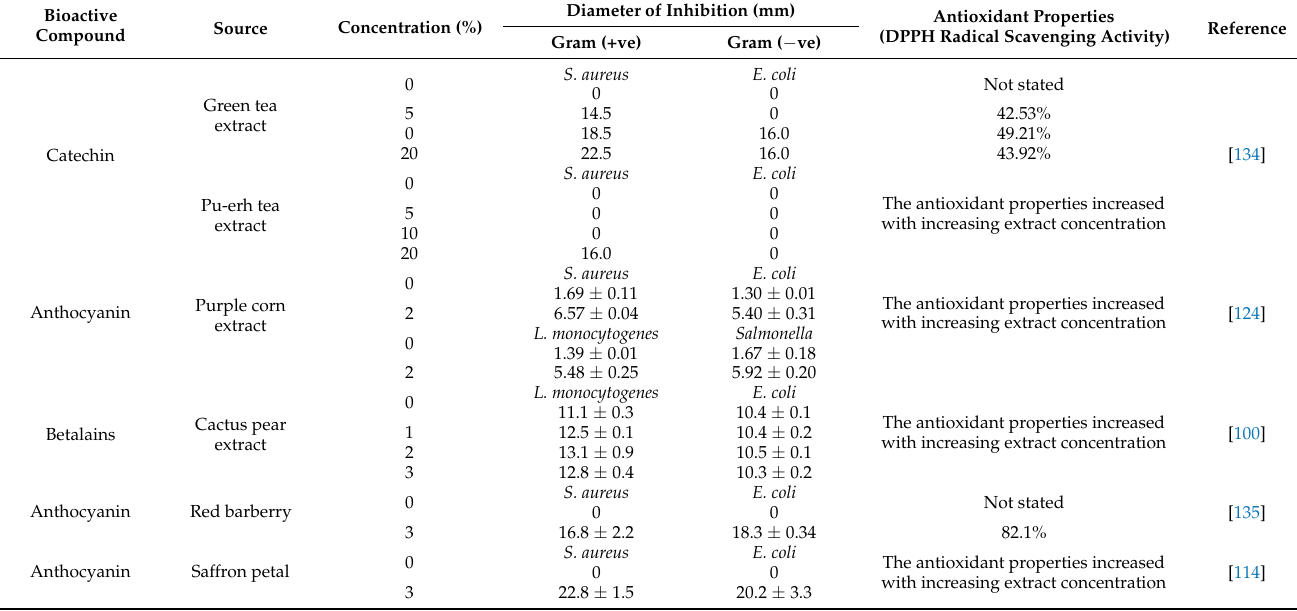
Table 5. Effect of natural extract on antimicrobial and antioxidant properties of film packaging as a color